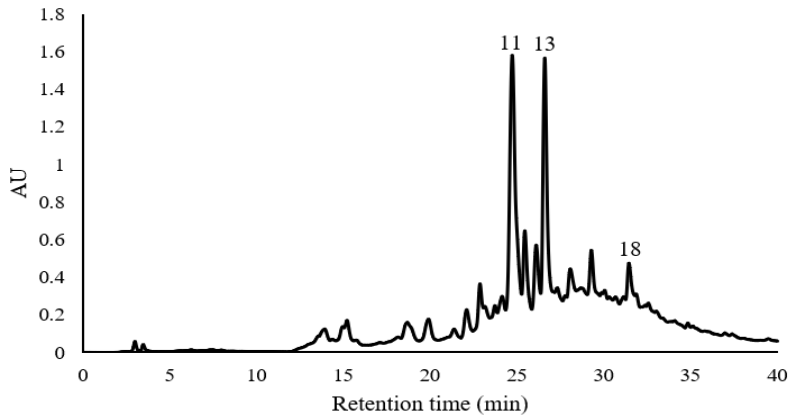
Figure 4. Chromatogram of the recovered polyphenols from Castilla Rose. Compound 11 Kaempferol 3,7-O-diglucoside; compound 13 procyanidin trimer C1; compound 18 ellagic